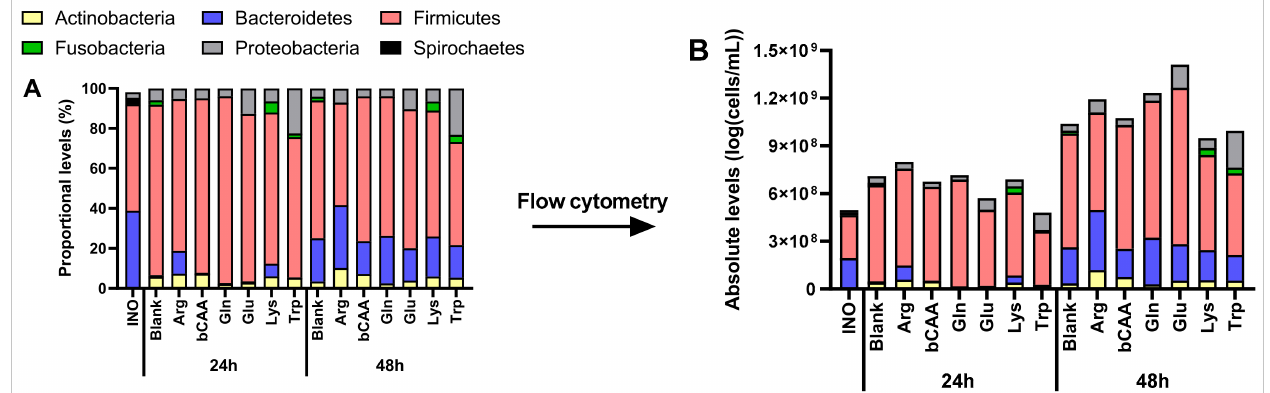
Figure 5. Impact of amino acids on microbial community composition (phylum level) during incuba- tions with a porcine colonic microbiota. Values are the average of three technical replicates ( n = 3) and are expressed both ( A ) as proportional values based on 16S rRNA gene profiling (%), and (B) as absolute values, estimated upon multiplying with total cell counts (cells/mL) ( B ). INO = inoculum. Like for microbial activity, the PCA based on microbial composition (at family level) explained a great part of the variation of the dataset (68%) (Figure 6A). Besides a clear impact of time (visualized by colocalization of samples of the three time points (0 h, 24 h and 48 h)), a second factor determining the positioning of samples in the PCA was the treatment with specific amino acids. Treatment effects were again most pronounced at 48 h as visualized by a more distant positioning of treatment samples versus the untreated blank as time progressed. In other words, at 24 but especially at 48 h, samples of the different treatments were positioned more distant from the untreated blank. Apparently, Arg exhibited a highly different microbial community.